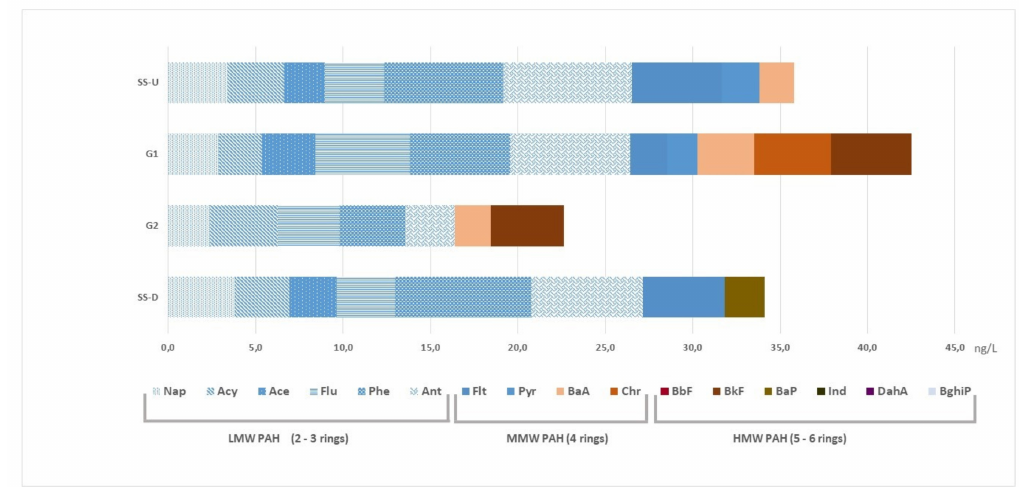
Figure 7. Composite model and average concentrations of PAHs in the studied